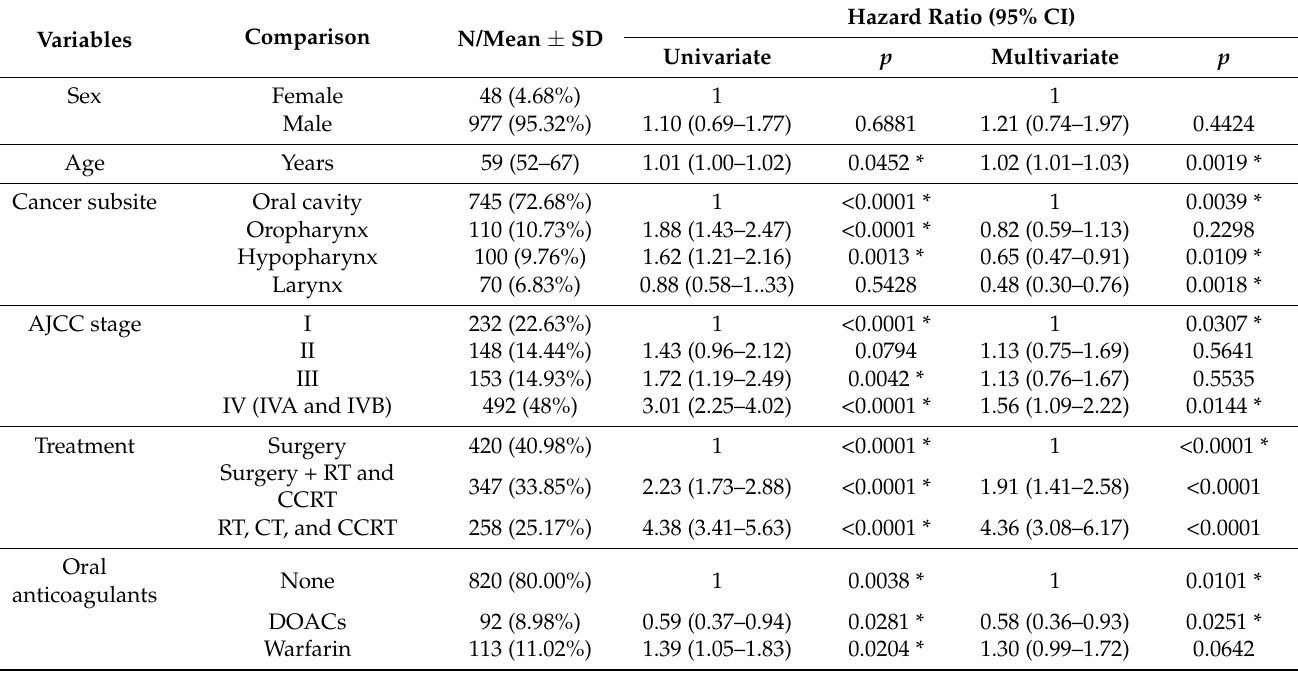
Table 5. Univariate and multivariate Cox regression model of prognostic factor for overall survival in study cohort ( n =